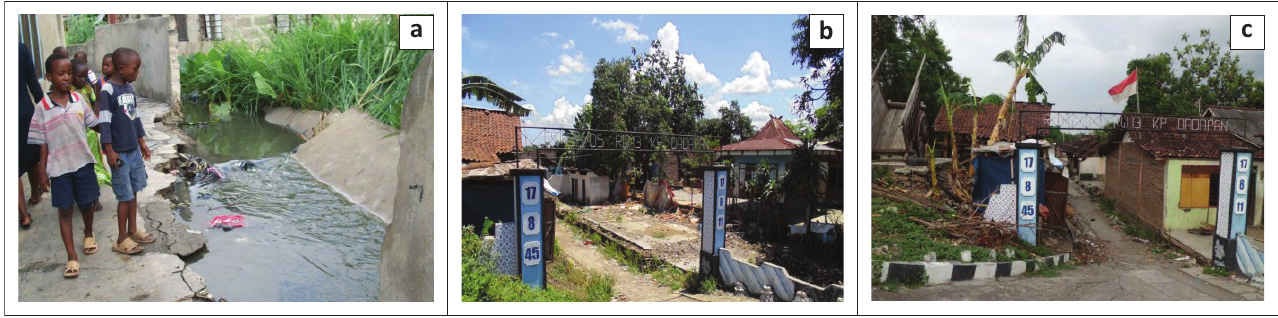
Source : Photographed by T. Sakijege FIGURE 4: Flood damage to properties as seen by, (a) collapsed protective wall in Keko Machungwa and (b) destroyed house in Sangkrah after flooding (c) same house before